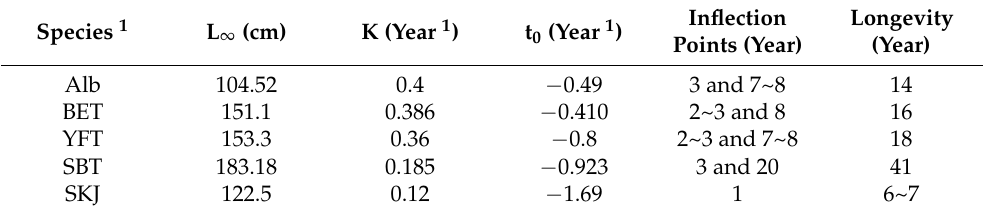
Table 1. Growth parameters of five tuna species.